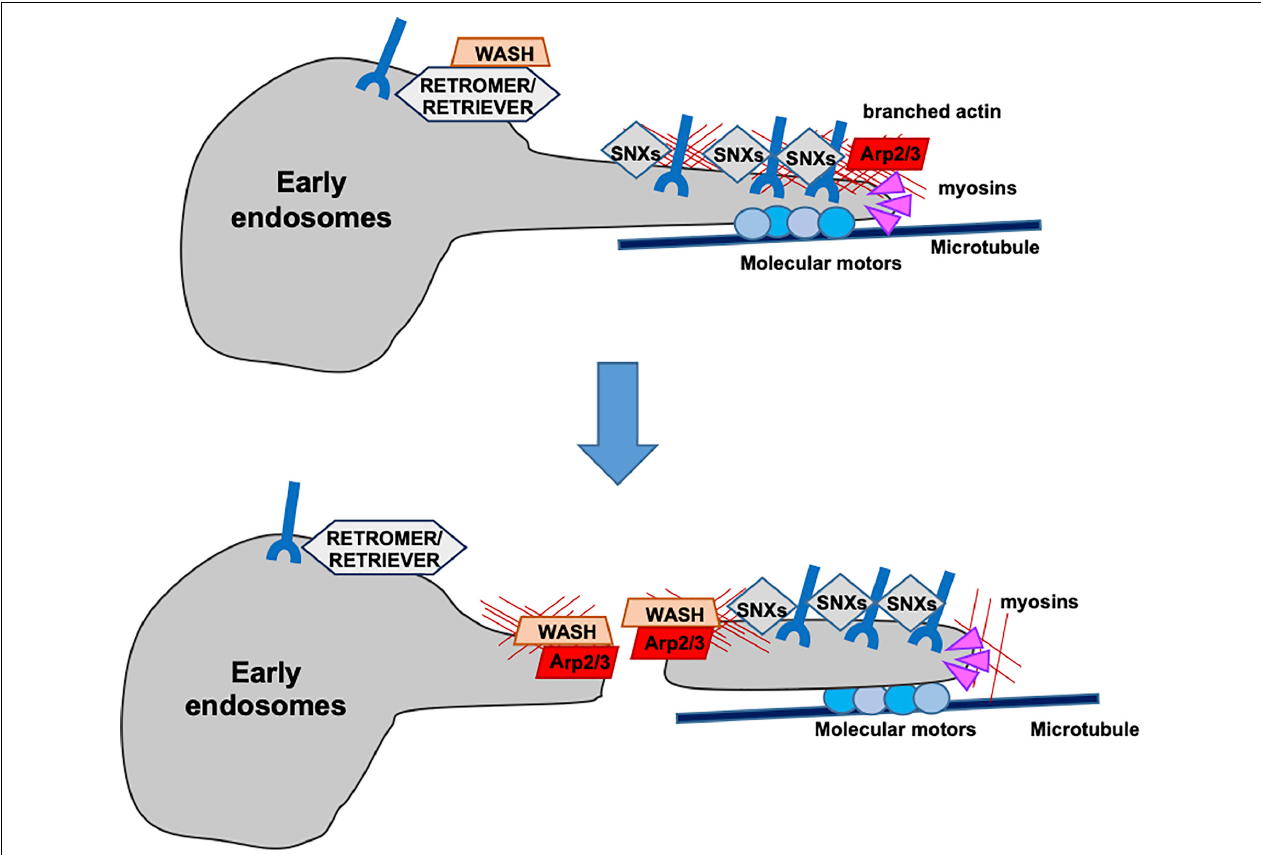
FIGURE 2 | Recycling of receptors through actin-rich tubular domains. Sequence-dependent recycling of cargoes is tightly regulated by actin dynamics at the surface of endosomes. The retrieving machineries (retromer or retriever), together with the WASH complex, allow for the entry of the receptors into tubular profiles enriched in F-actin and actin-related proteins. Microtubule motors drive the stabilization and extension of the tubular profiles and branched F-actin contributes to vesicle